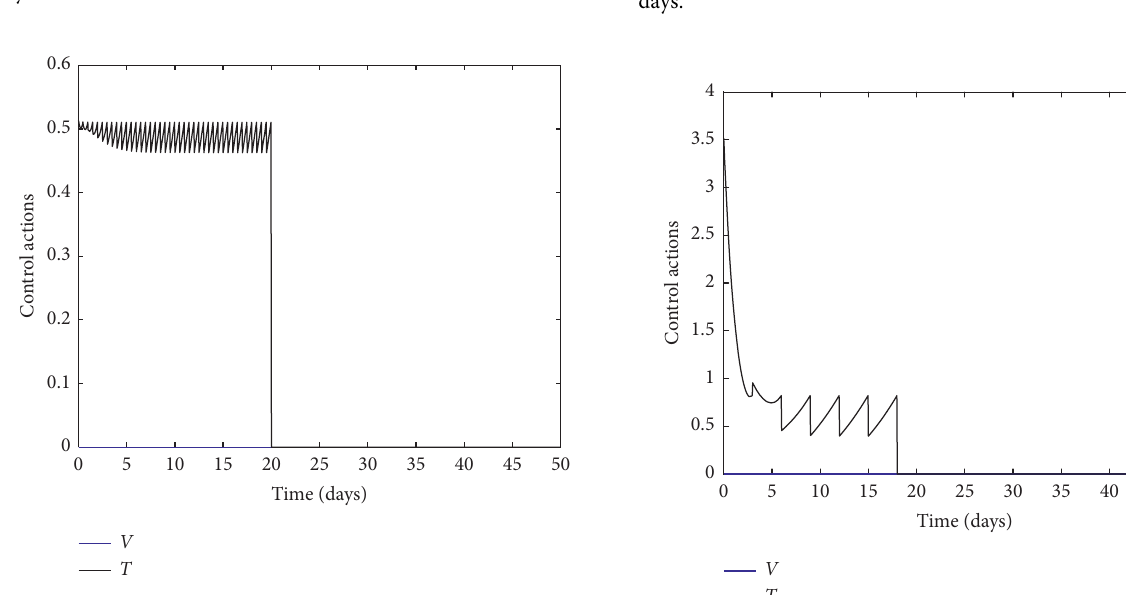
Figure 12: Control efforts when Δ t � 12 hours and n � 20 days.